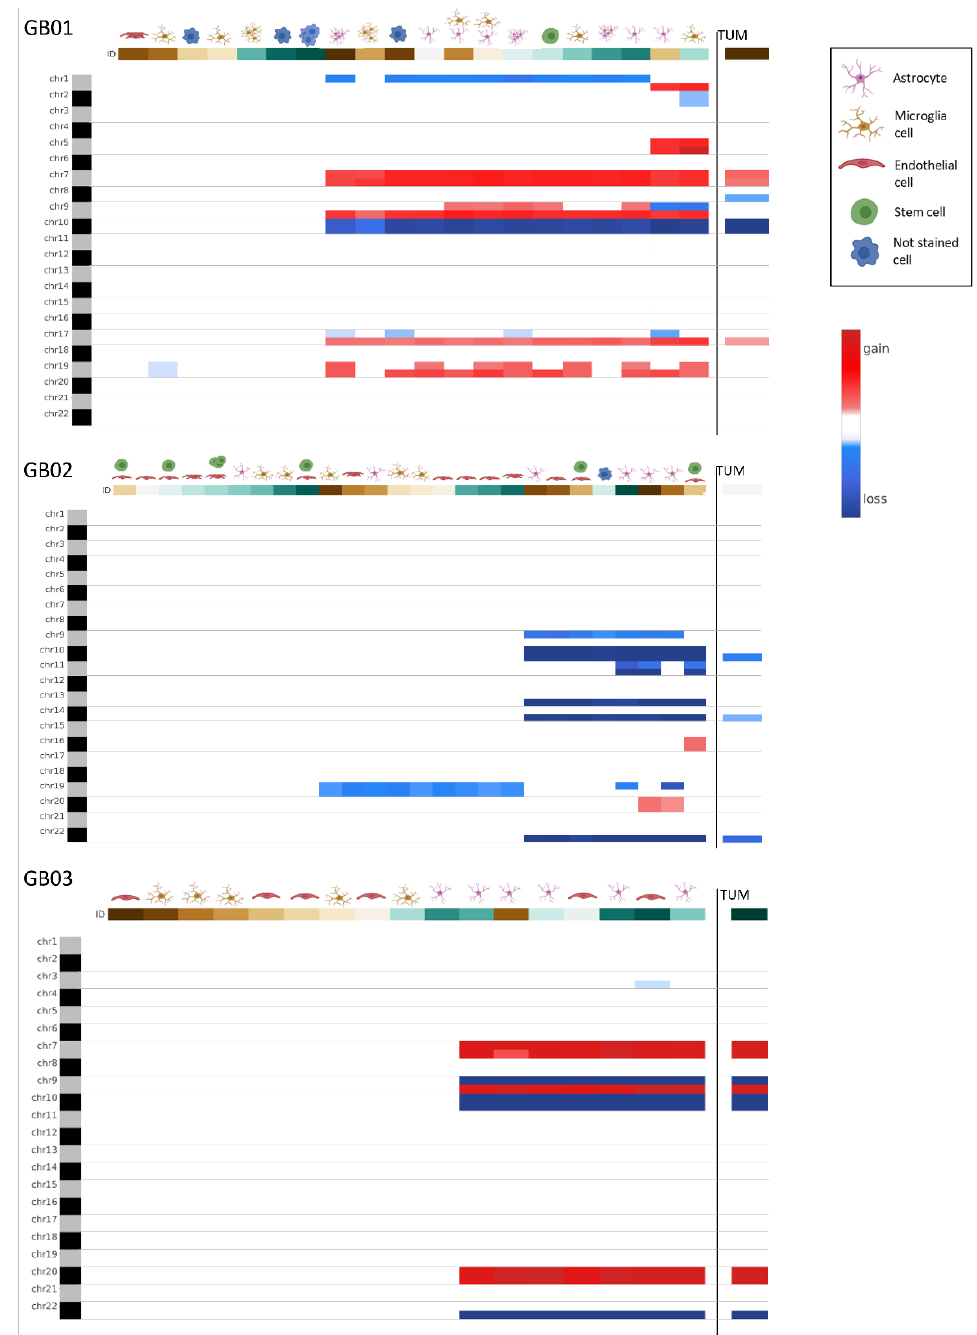
Figure 6. Genome-wide chromosome arm CNA profile heatmap for GB01, GB02, and GB03. For each sample, the CNA profile of the single cells collected is shown and on the right the CNA profile of the tumor tissue in bulk.